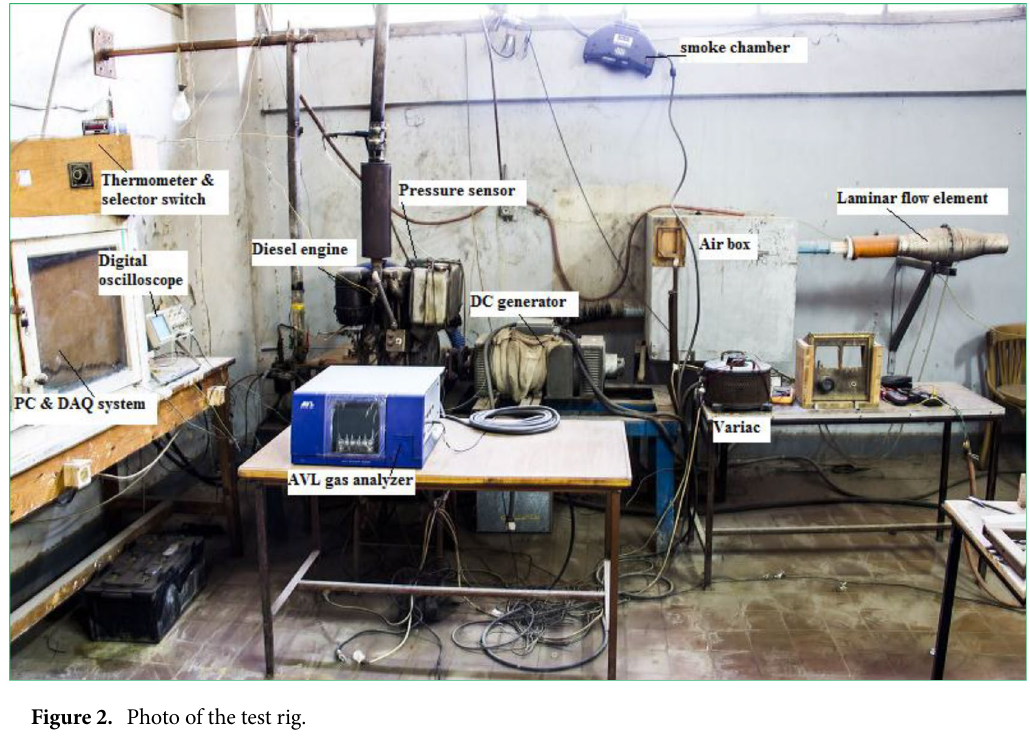
Figure 2. Photo of the test